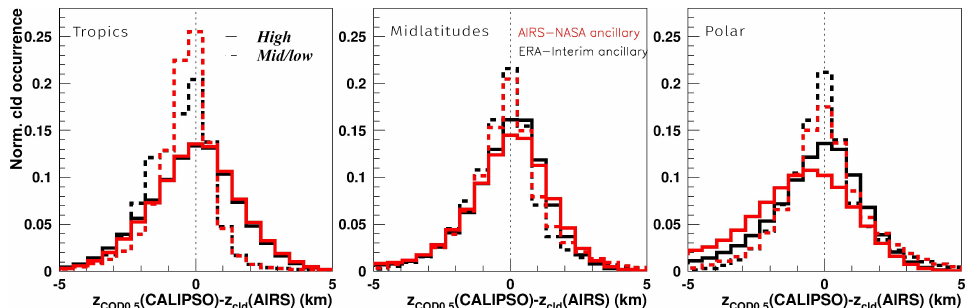
Figure 3. Normalized frequency distributions of the difference between the cloud height at which the optical depth reaches a value of 0.5 from CALIPSO and z cld from AIRS; z cld is compared to the cloud layer of CALIPSO, which corresponds to the CloudSat lidar GEOPROF, and is the closest to z cld (Sect. 2.4). Analysis over tropics (30 ◦ N–30 ◦ S), midlatitudes (30–60 ◦ ) and polar latitudes (60–85 ◦ ), separately for high-level clouds and for clouds with p cld >440hPa. The effect of using different ancillary data is also presented. Statistics include 3 years (2007–2009) of observations at 01:30LT. Table 1. Hit rates between AIRS-CIRS and CALIPSO–CloudSat cloud detection. Statistics include 3-year (2007–2009) collocated observa- tions at 01:30LT. Surface/latitude Tropics Midlatitudes Polar Ancillary data AIRS ERA AIRS ERA AIRS ERA Ocean 86.5% 84.2% 90.2% 91.5% 93.0% 95.0% Land 86.4% 83.2% 80.7% 77.6% 77.3% 79.7% Sea ice 71.5% 82.0% 71.2% 81.2% Snow 73.5% 71.9% 74.9% 68.5% 65.5%